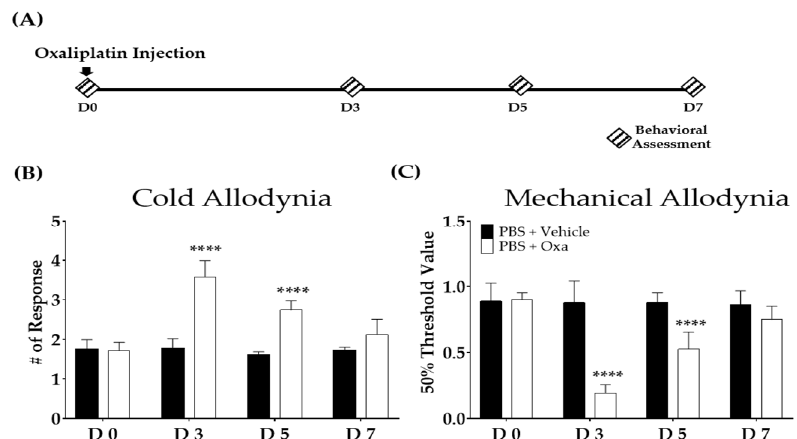
Figure 1. The effect of a single intraperitoneal oxaliplatin injection in mice. Schedule for experiments conducted to assess the degree of the cold and mechanical forms allodynia after oxaliplatin injection ( A ). Cold ( B ) and mechanical ( C ) allodynia after oxaliplatin injection. N = 6 each group. Note: **** p < 0.0001 vs. vehicle with two ‐ way ANOVA followed by Sidak’s post ‐ test for multiple comparisons. The ANOVA test found interaction F ‐ values of 32.8 and 28.1 for the cold and mechanical forms of allodynia, respectively.